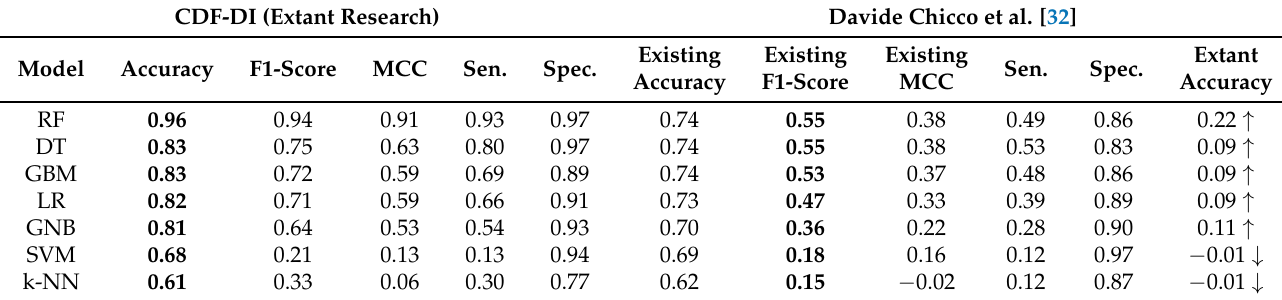
Table 19. Benchmark with previous study